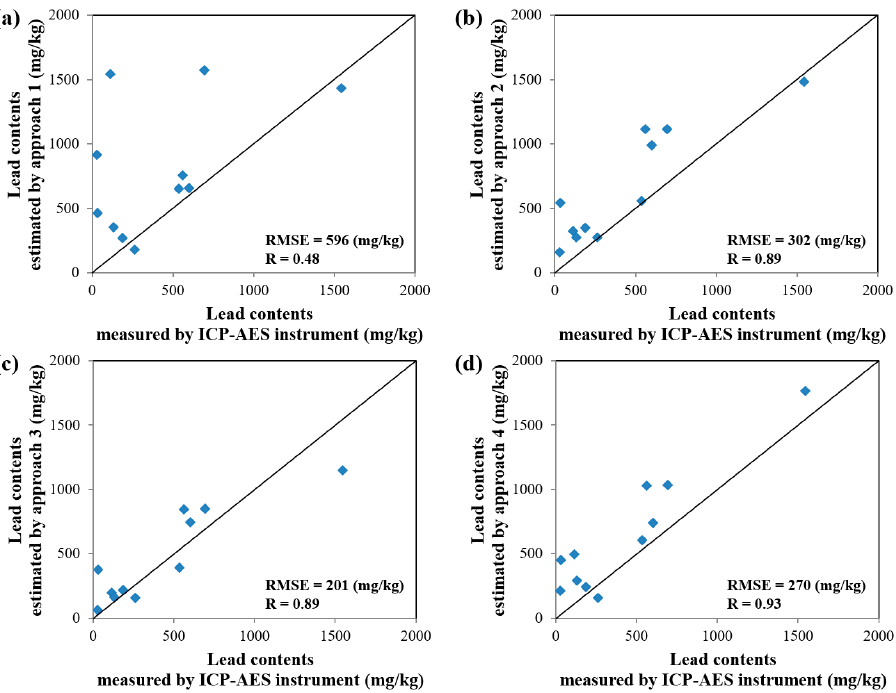
Figure 10. Plot showing the correlation of ICP–AES analysis data and estimated values of lead content in soil contamination maps generated by approaches: ( a ) 1; ( b ) 2; ( c ) 3; and ( d ) 4.